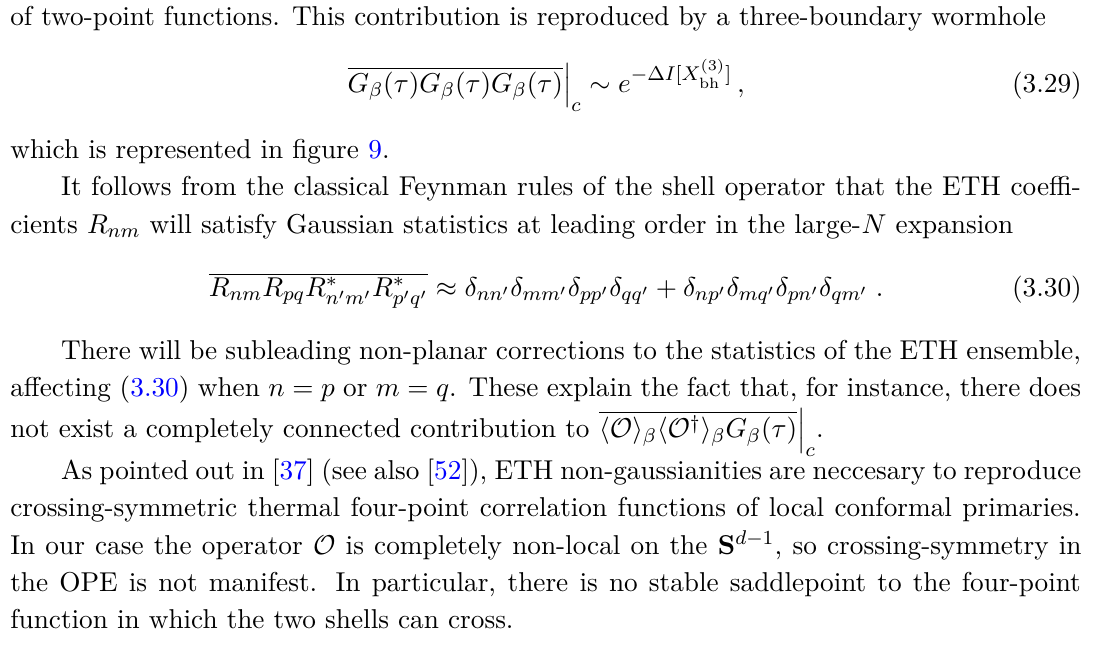
Figure 9 . Three-boundary wormhole X (3) masses M ± along the trajectories of three thin